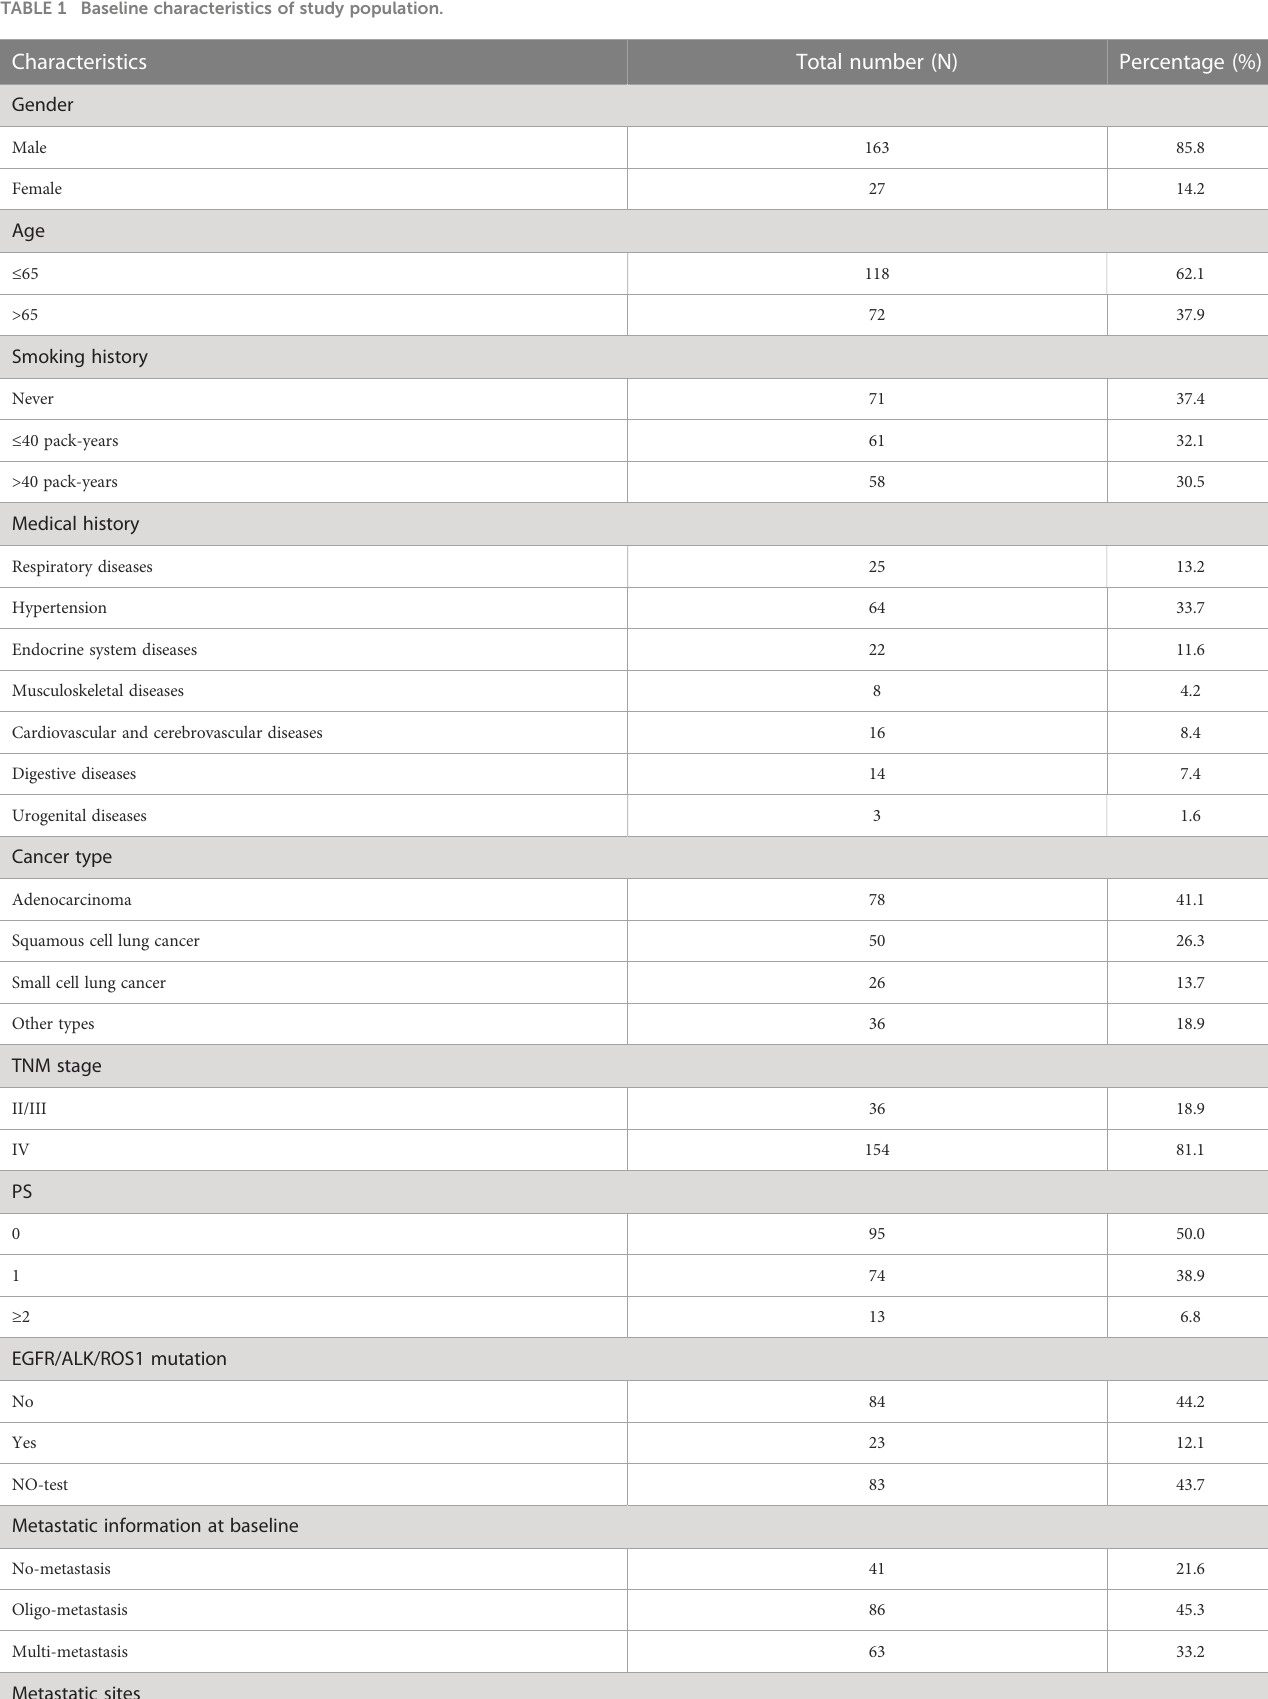
TABLE 1 Baseline characteristics of study